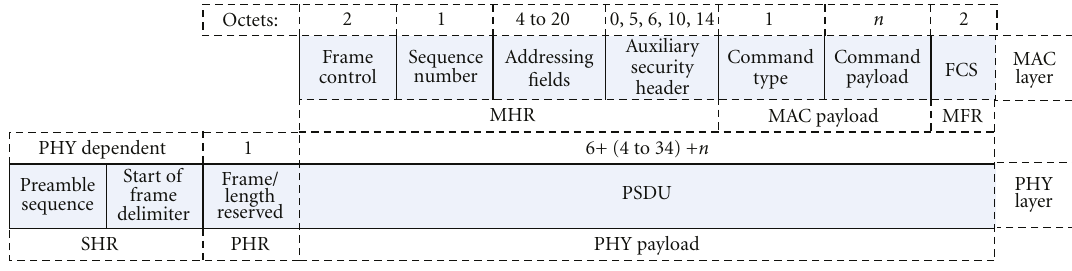
Figure 5: MAC command frame and the PHY packet.